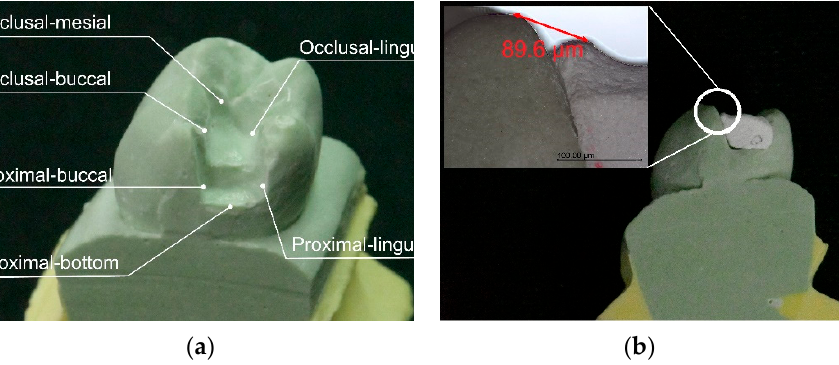
Figure 2. ( a ) Schematic diagram for measuring the marginal discrepancy of the inlays in this study is shown. ( b ) The marginal discrepancy of occlusal–buccal to sample is shown.